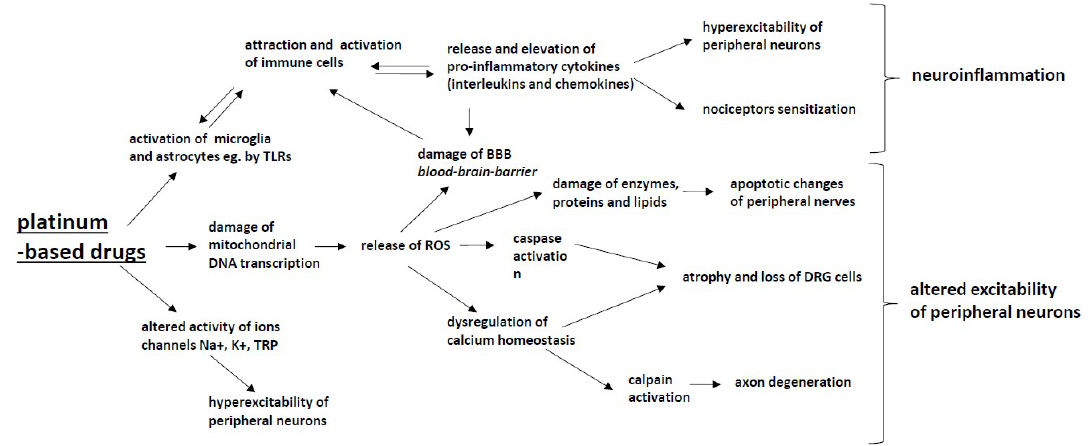
Figure 1. The mechanisms of chemotherapy-induced peripheral neuropathy (CIPN) induced by platinum-based drugs: Platinum-based drugs induce the activation of glia cells, which leads to the activation of the attraction and activation of immune cells and to the release and elevation of pro-inflammatory cytokines (interleukins and chemokines), which results in nociceptor sensitization and hyperexcitability of peripheral neurons, and (together with ROS) damage the blood–brain barrier. These processes lead to the development of neuroinflammation. Mitochondrial damage caused by platinum-based drugs leads to an increased production of reactive oxygen species (ROS), which leads to enzyme, protein and lipid damage within neurons as well as the dysregulation of calcium homeostasis, which induces apoptotic changes in peripheral nerves and in DRG cells. Platinum-based drugs also alter the activity Na+, K+ and TRP ion channels, resulting in the hyperexcitability of peripheral neurons. All of the above-described processes have the potential to alter the excitability of peripheral neurons.